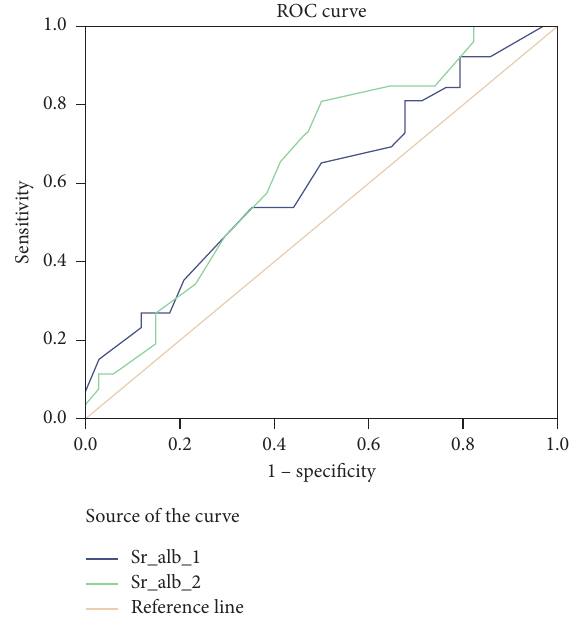
Figure 2: ROC curve analysis of serum albumin 1 and serum albumin 2 as prognostic markers of ICU